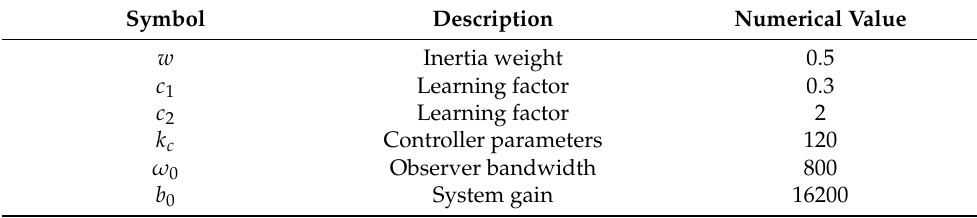
Table 3. MPPT controller